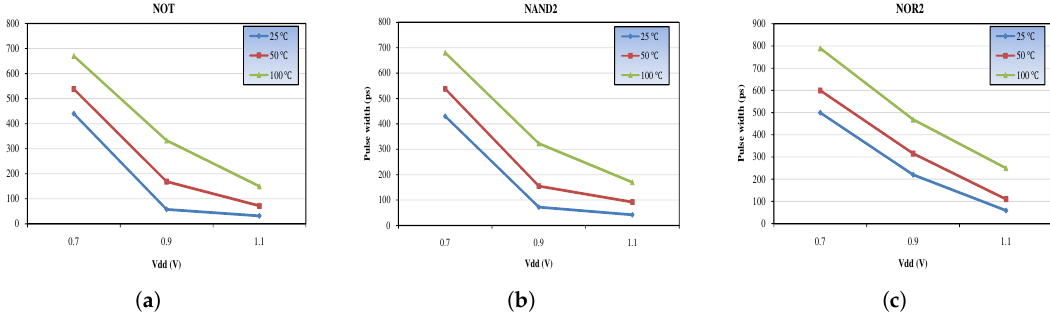
Figure 3. Pulse widths for different supply voltages and temperatures of ( a ) NOT, ( b ) NAND2 and ( c ) NOR2 gates.